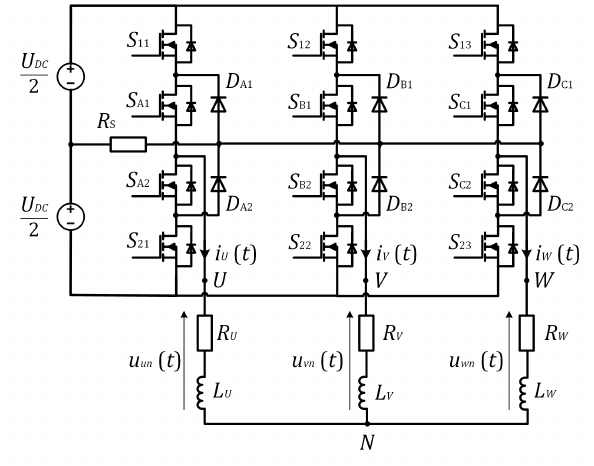
Figure 1. Three-level DC–AC